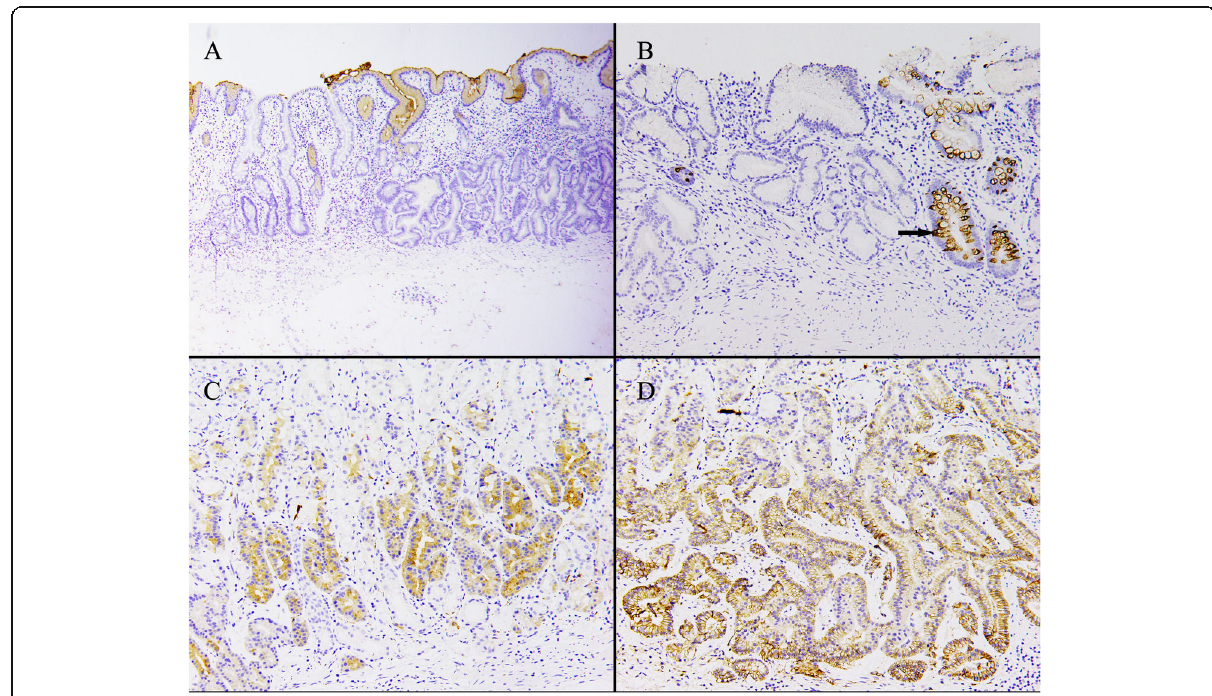
Fig. 6 Immunohistochemical studies revealed that a MUC5 was negative in all tumor cells, but was positive in foveolar cells. b MUC2 was positive in the gland with intestinal metaplasia(arrow). Tumor cells were positive for SYN ( c ) and CD56 ( d